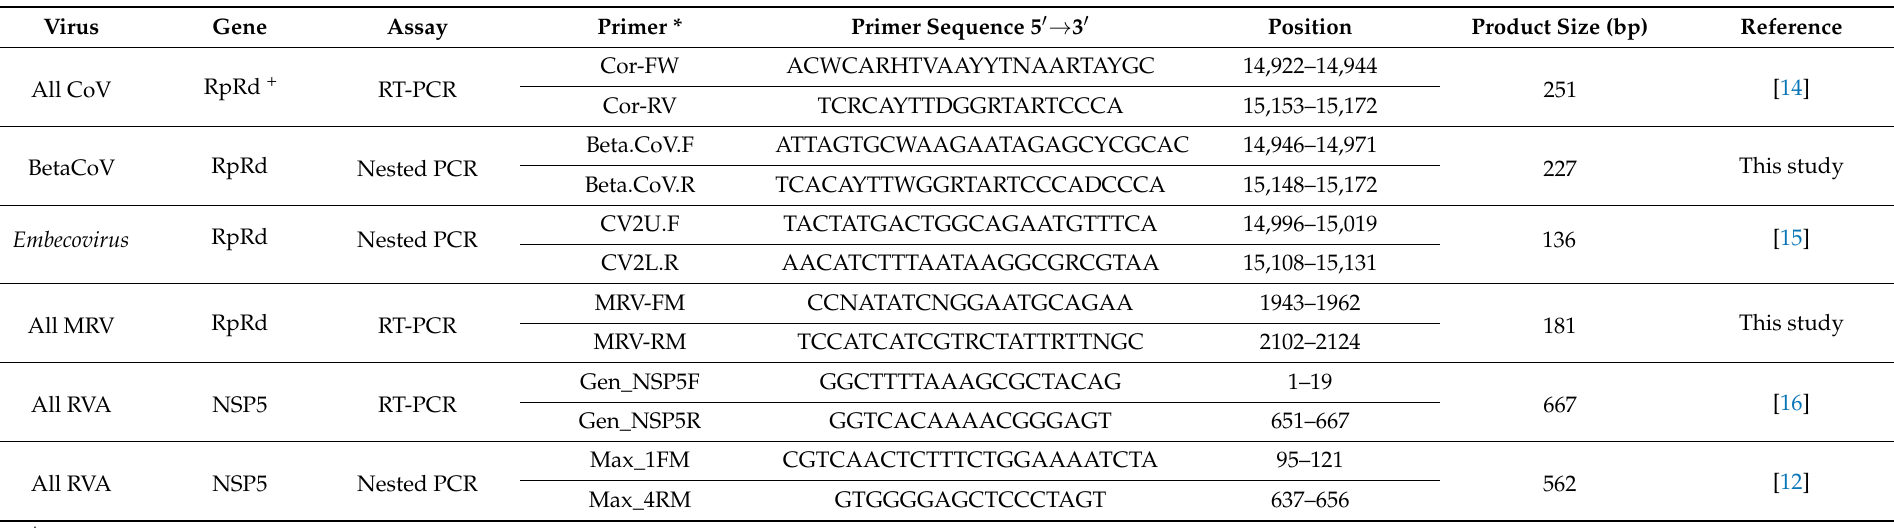
Table 1. Primers used in the RT-PCR and nested PCR assay for CoV, MRV, and RVA detection †